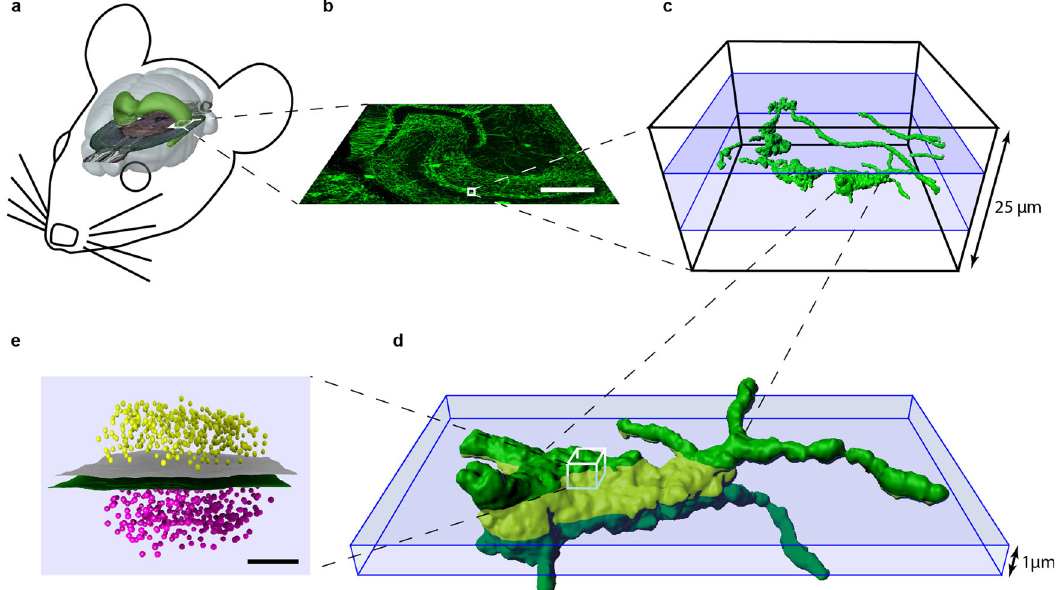
Fig. 1 Schematic overview for targeted imaging of hippocampal mossy fi ber synaptic contacts. a View of a virtual mouse brain with the dimensions of the hippocampal formation in green and a horizontal section from Allen Mouse Brain Atlas (image credit: Allen Institute for Brain Science, available from: http://mouse.brain-map.org/static/brainexplorer) to demonstrate the hippocampal region used for imaging (white box). b Confocal image of mossy fi bers in a 25 µ m thick hippocampal slice from a Thy1mEGFP(Lsi1) mouse. The white box marks again the region of interest (25 µ m × 25 µ m × 25 µ m) that is shown magni fi ed in the next panel. c 3D volume reconstruction of mEGFP in xyz -view, showing axons and mossy fi ber boutons (green), a typical bouton with fi lopodial extensions is marked and further highlighted in d . The window (10 µ m in z ) for en bloc imaging in the 25 µ m thick tissue block is shown in blue. d 3D volume reconstruction of a mossy fi ber bouton. The light green area of the bouton shows the volume that would be captured using a typical 1 µ m imaging depth in z for a single focal plane. The white box marks a virtual synaptic contact that is further magni fi ed in the next panel. e A virtual synaptic contact in side view (presynaptic membrane in green, Bassoon clusters in magenta, Homer-1 in yellow, postsynaptic membrane in gray), scale bar in b 200 µ m, in e 100